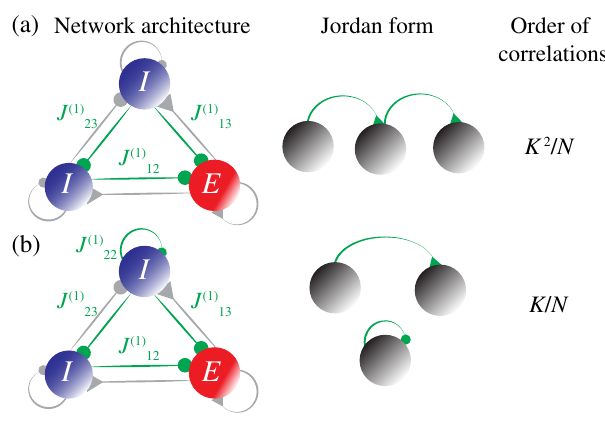
FIG. 6. Examples of networks with three populations and their Jordan representations. Probability of connections are as in Eq. (37). (a),(b) Left: A network of three populations, two inhibitory and one excitatory. Gray: Unstructured connections. Green: Spatially modulated connections. Middle: The Jordan representation of the n ¼ 1 Fourier mode of the network connectivity (left panel). Right: The scaling of the strongest 1 Þ ð 1 Þ ð 1 Þ ≠ 0 . Other entries of the matrix correlations. (b) J ð 12 , J 13 , J 23 J ð 1 Þ are zero (see main text). Same as (a) but with J ð 1 Þ ≠ 0 22